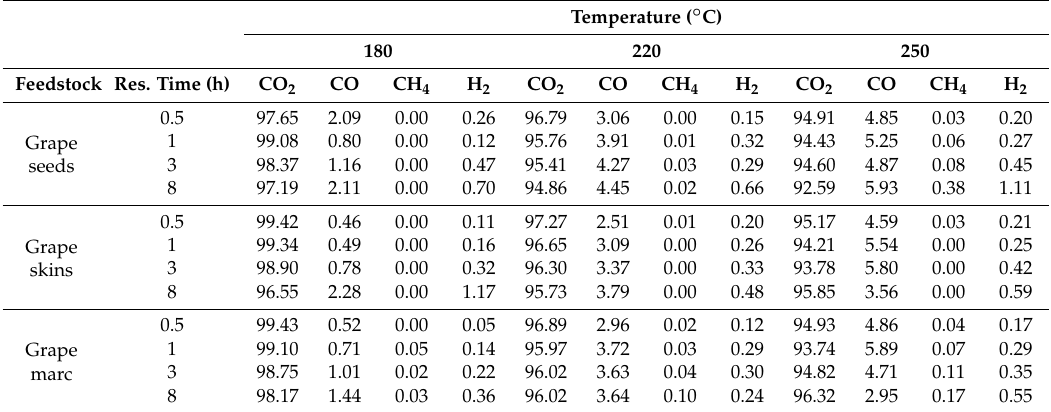
Table 5. Gas composition at different process